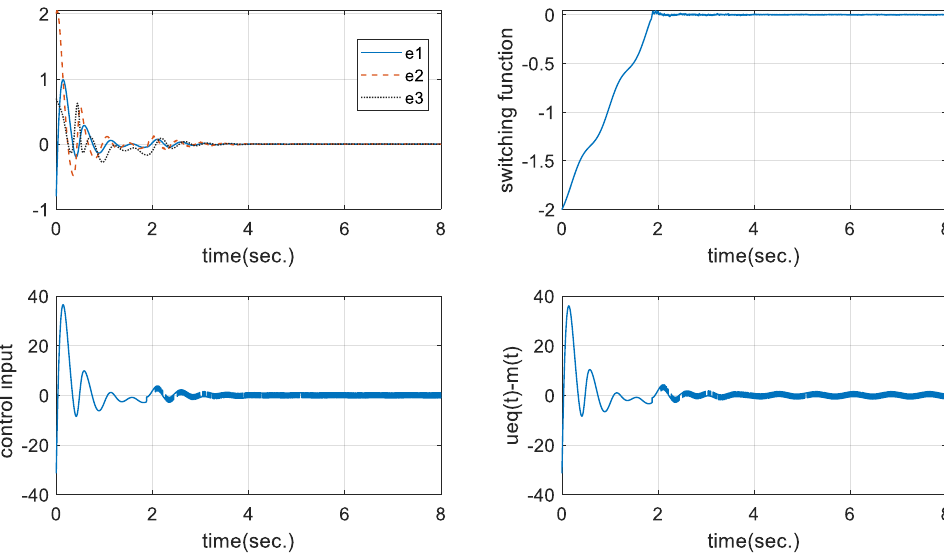
Figure 5. Controlled system responses with discontinuous SMC.